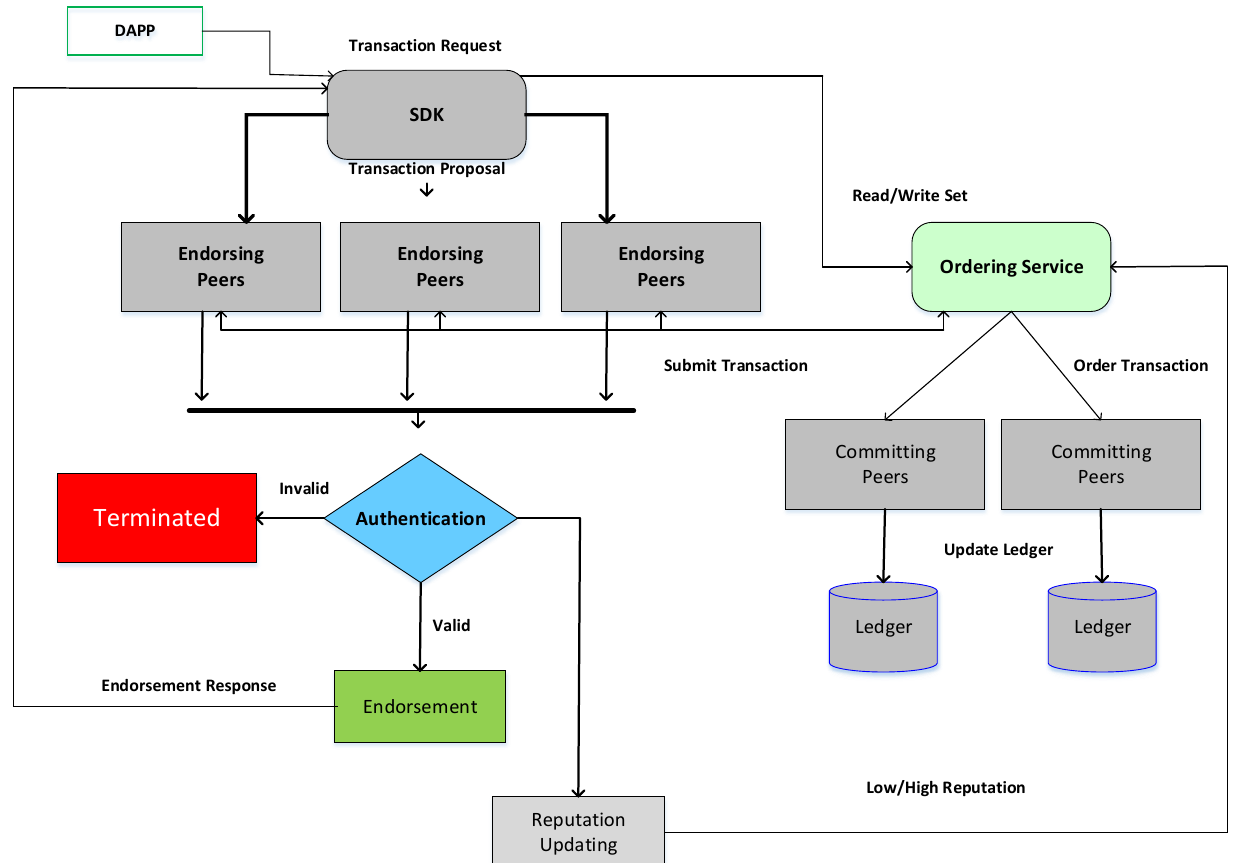
Figure 2. Flow diagram of enhanced Fabric.